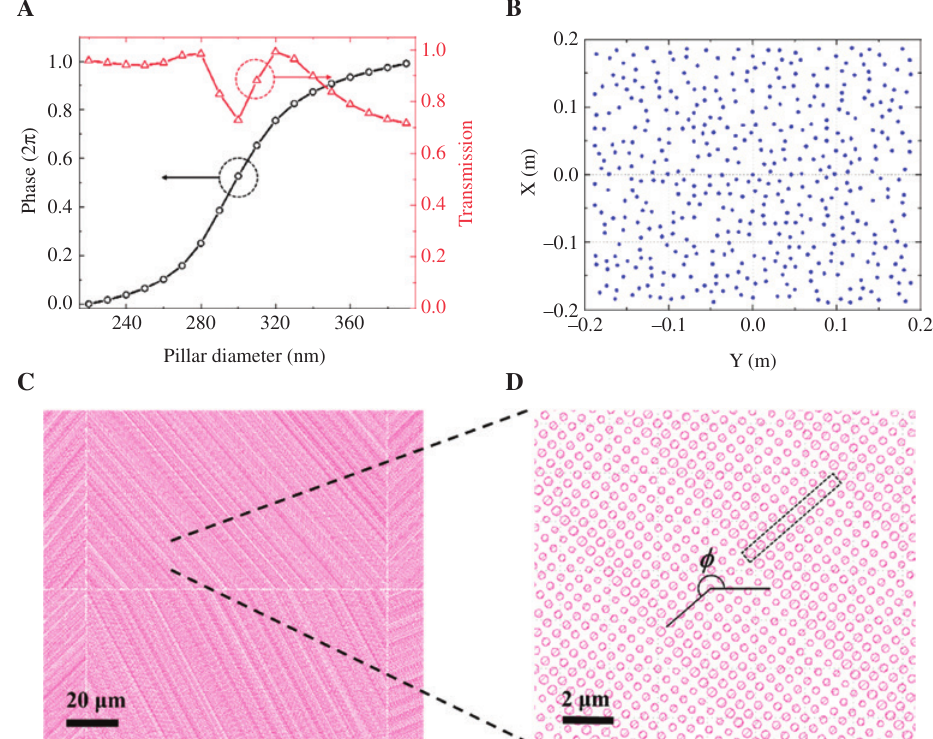
Figure 2: Design of the large-area pixelated metasurface beam deflector. (A) Simulation of phase shift and transmission of building block for beam deflector (a-Si nanopillar with a unit cell of 545 nm and height of 145 nm embedded in dielectric media) as a function of diameter. (B) Designed 441 random point positions (relating to the bending angles θ and the orientation angles φ ) on a screen with distance of 1 m away from the pixelated metasurface beam deflector. (C) Layout mask for the designed metasurface, showing pixel boundaries. (D) Zoomed-in view of (C), showing a supercell of beam deflector (denoted by a dotted rectangle) and nanopillar array with a designed